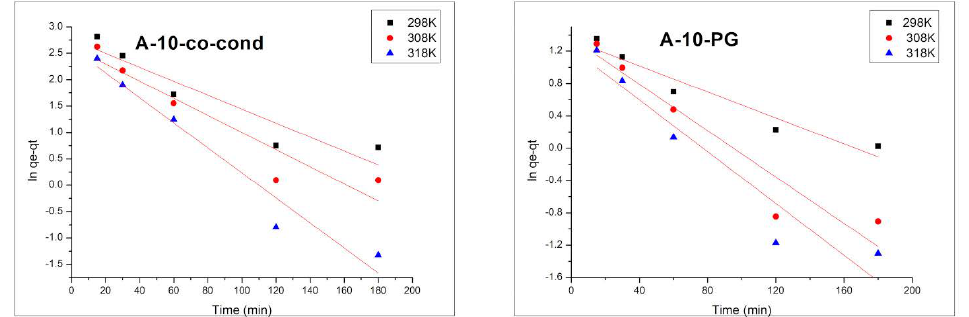
Figure 9. Pseudo-fist order kinetic model for the A-10-co-cond ( left ) and A-10-PG ( right ) samples.